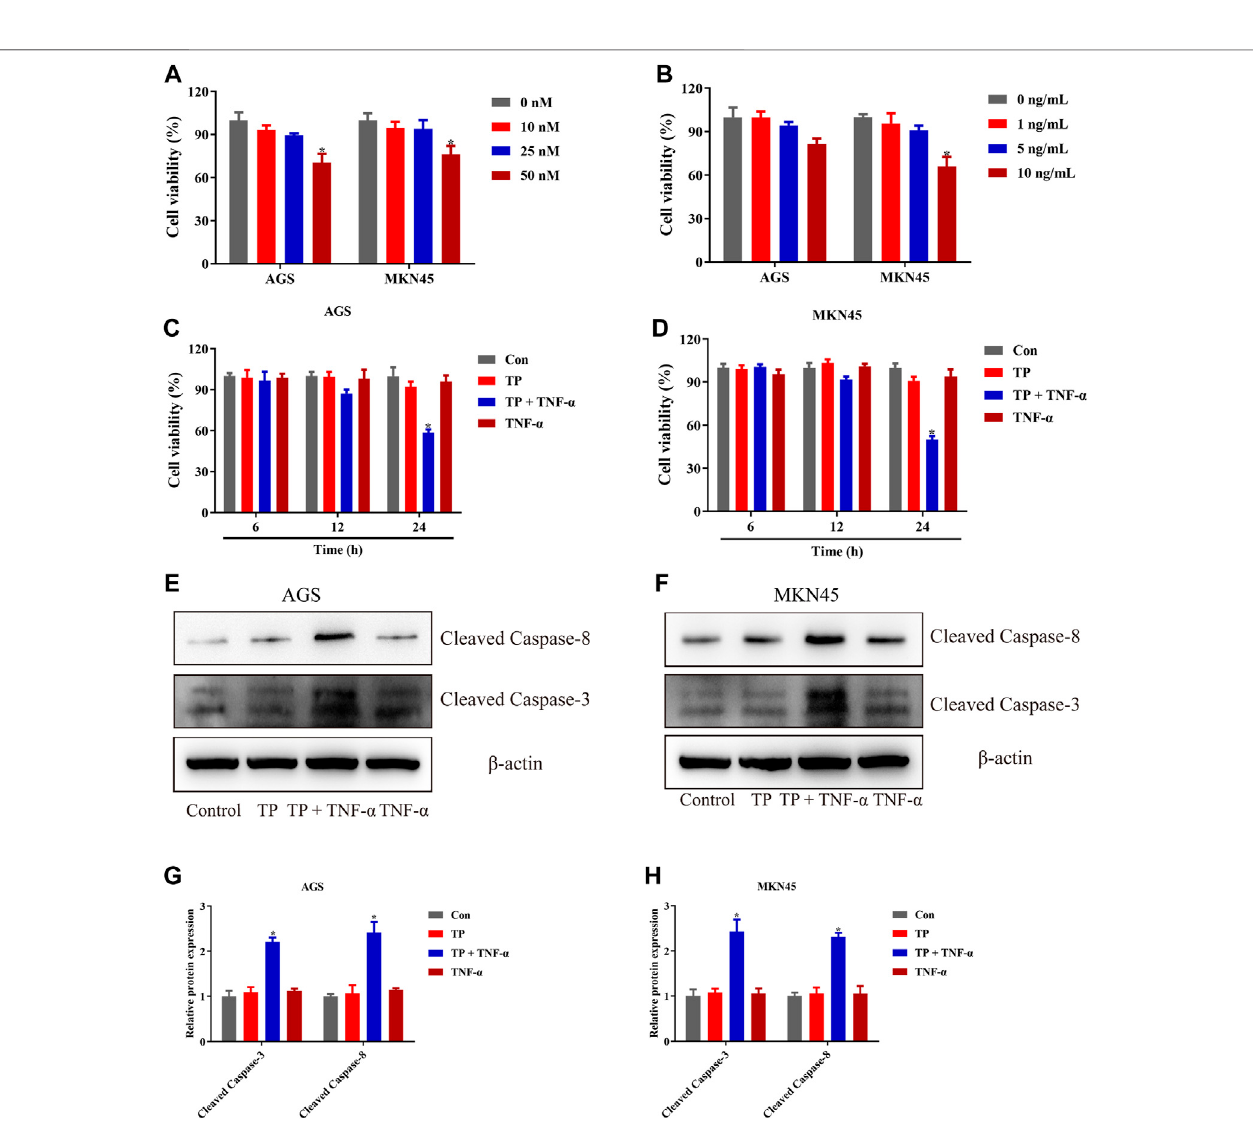
FIGURE 1 | TP pretreatment increased the sensitivity of AGS and MKN45 cells to TNF- α . (A) Cell viability of AGS and MKN45 cells treated with different concentrations of TP between 10 and 50 nM for 24 h. (B) Cell viability of AGS and MKN45 cells treated with different concentrations of TNF- α ranging from 1 ng/ml to 10 ng/ml for 24 h. (C – D) Cell viability of AGS and MKN45 cells treated with TP (25 nM) and TNF- α (5 ng/ml) for 6, 12, and 24 h. (E – H) Representative Western blots and relative intensity of protein bands of cleaved caspase-3 and cleaved caspase-8 of AGS and MKN45 cells treated with TP (25 nM) and TNF- α (5 ng/ml), 24 h after TNF- α application, with β -actin as the loading control. Results were expressed as mean ± SEM, and statistical analysis was performed using one-way ANOVA or two- way ANOVA followed by Tukey ’ s multiple comparison test. * p < 0.05 ( n ≥ 3). * p compared with the control group.